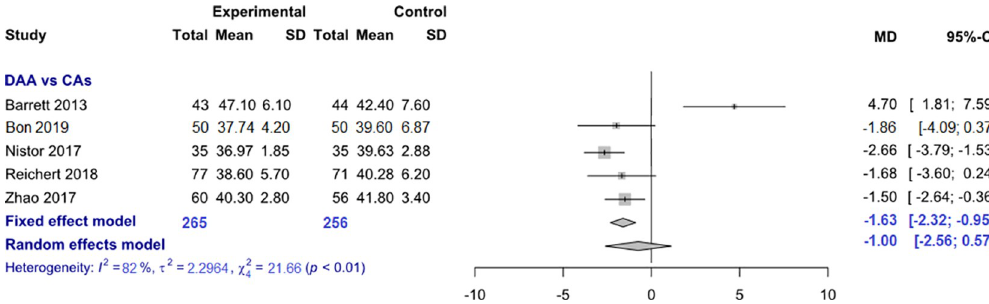
Fig 10. Comparison of the acetabular cup inclination angle in degrees. DAA, direct anterior approach; CAs, conventional approaches; SD, standard deviation; MD, mean difference; CI, confidence